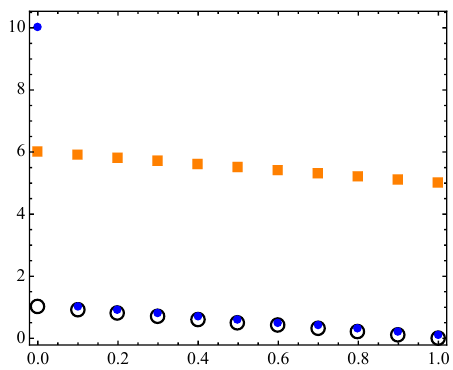
Figure 7. A hypothetical Pareto front discretization P (cid:48) (black circles) and two different archives: X 1 (blue dots) and X 2 (orange